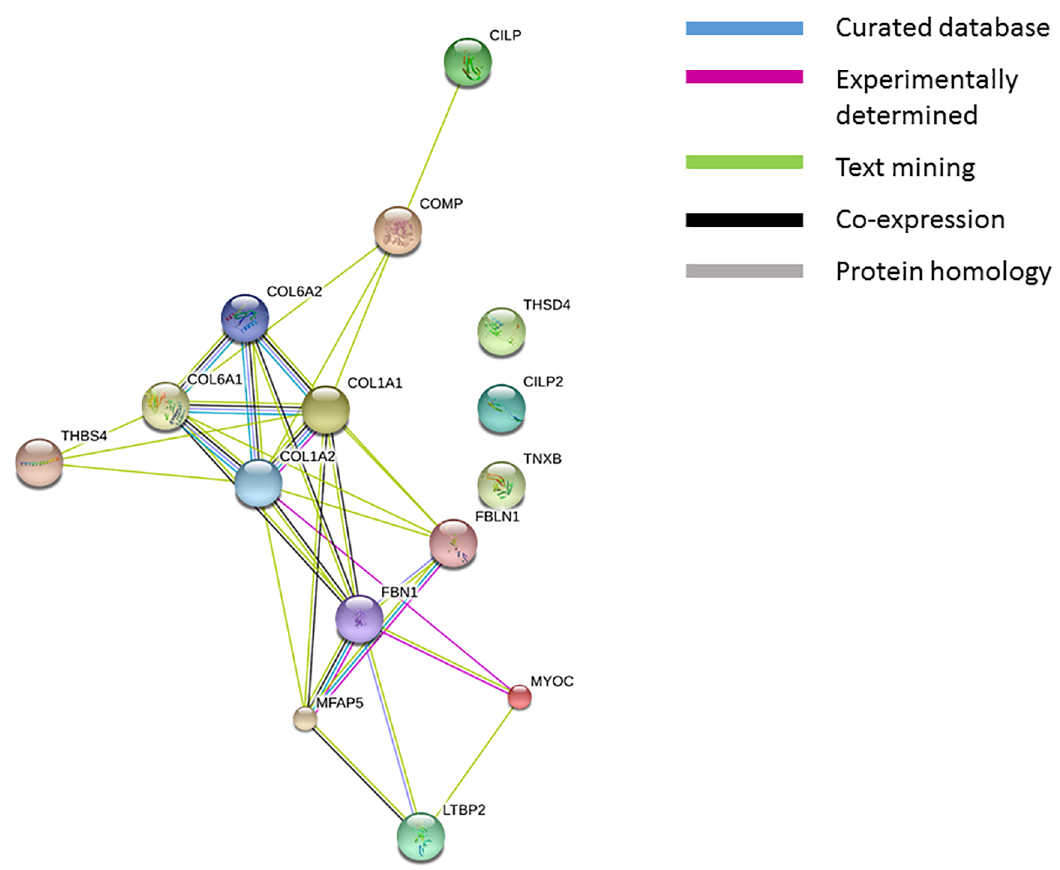
Fig 5. The interactions of all proteins which were significantly reduced in torn samples compared to control, createdusing the STRING database. The different line colours represent the different types of associationsbetweenthe differentially modulated proteins, which includeknown interactionssuch as those identified in the curated database(light blue), and experimentally determined(purple).Other interactionsidentifiedwere via text mining(green), co-expression (black) and protein homology(grey). Proteins are: COL1A1, Collagen1(I); COL1A2, Collagen2(I); COL6A1, Collagen1 (VI); COL6A2, Collagen2(VI); FBLN1, Fibrillin-1; MFAP5, microfibrillarassociatedprotein 5; COMP, Cartilageoligomeric protein;THSD4, Thrombospondin-4;CILP1, Cartilageintermediatelayer protein 1; CILP2, Cartilageintermediate layer protein 2; TGFB1, Latent-transforming growth factor beta-binding protein 2; FBN1, Fibulin-1;TNXB, Tenascin-X; MYOC,